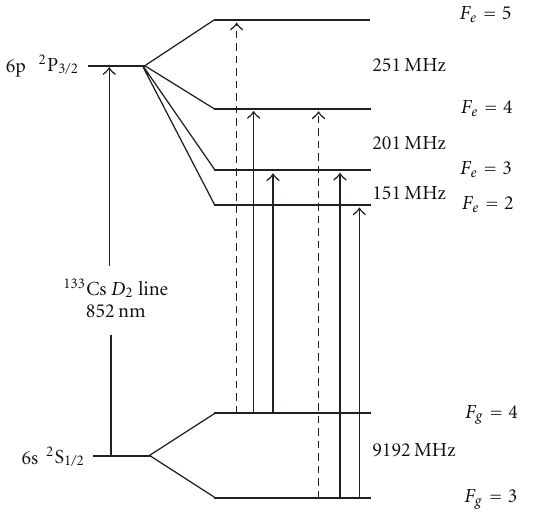
Figure 1: Energy-level diagram for D 2 line of Cs. The F g → F e ≤ F g transitions (solid line) are distinguished from the F g → F e > F g transitions (dashed